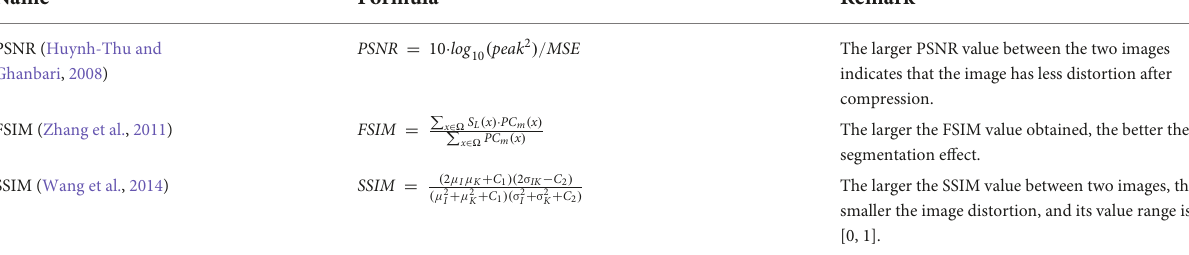
TABLE 8 Image quality evaluation